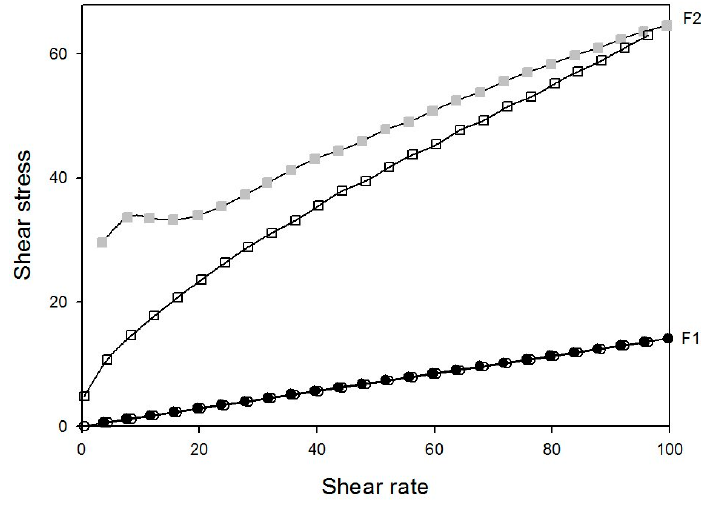
Figure 5. Rheograms of systems composed of poloxamer 407 dispersion (1%), oleic acid, and PPG-5-CETETH-20. Closed and open symbols indicate going and return, respectively. Data were collected at 37 °C. Table 2. Rheological parameters of hydrogels composed of poloxamer 407 dispersion (1%), oleic acid, and PPG-5-CETETH-20 systems.